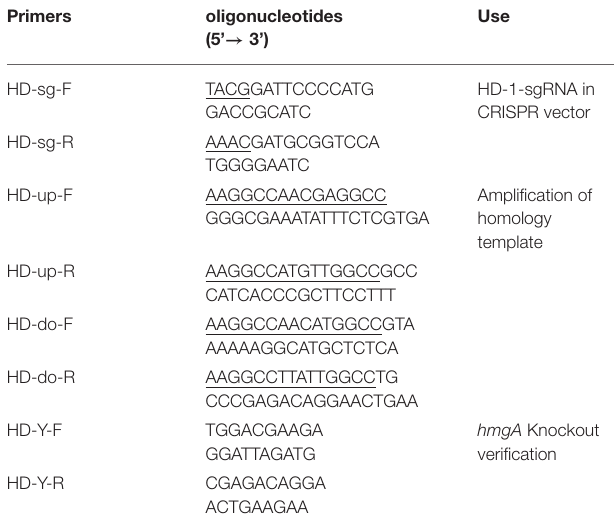
TABLE 2 | Primers used in this